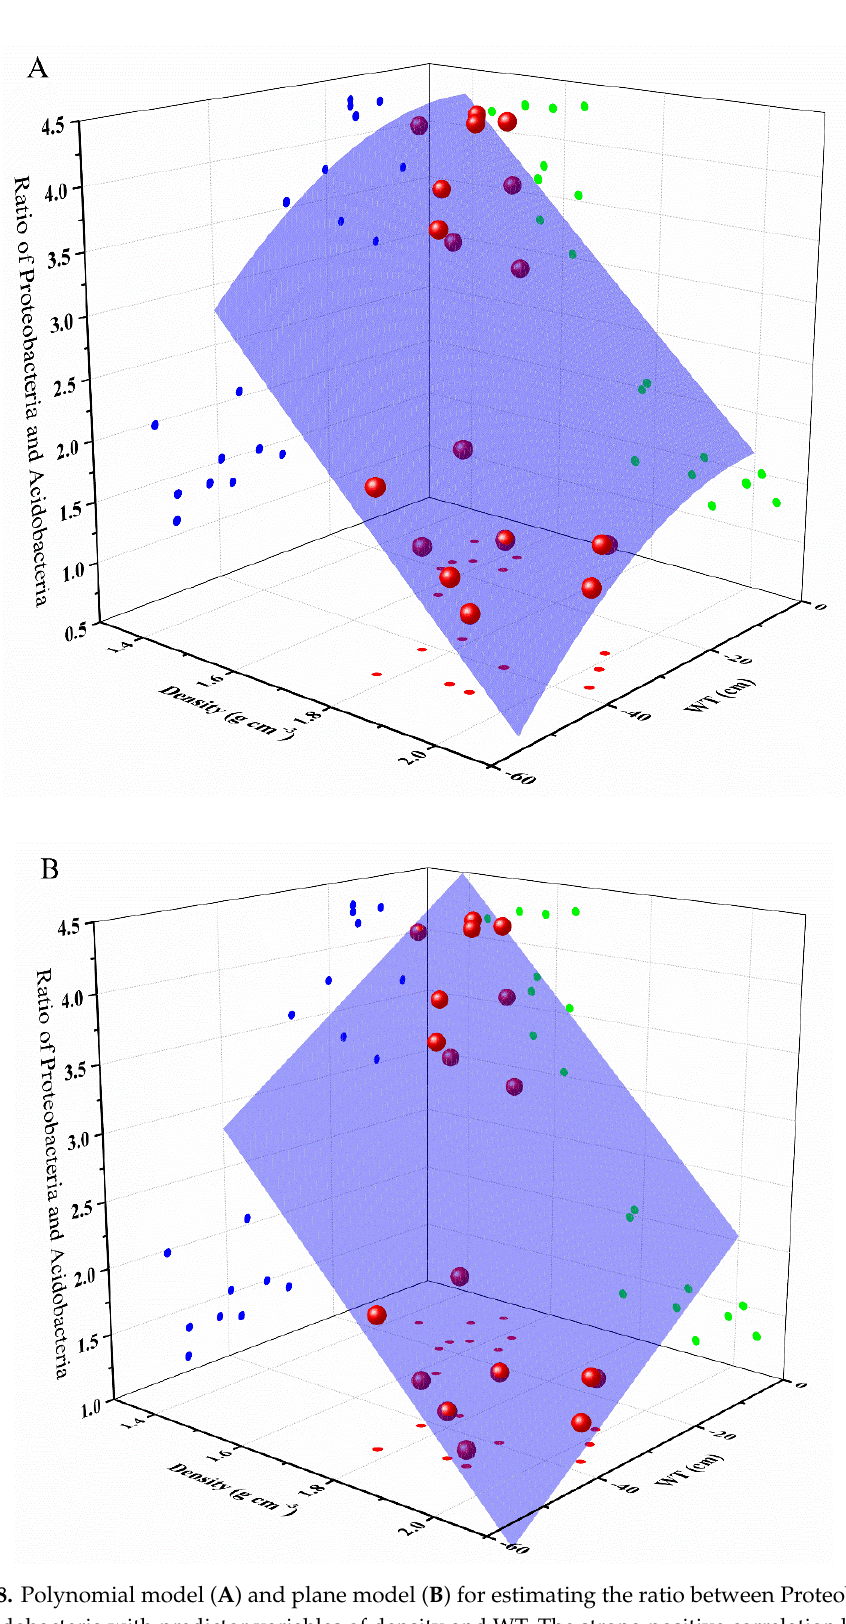
Figure 8. Polynomial model ( A ) and plane model ( B ) for estimating the ratio between Proteobacteria and Acidobacteria with predictor variables of density and WT. The strong positive correlation between the ratio and WT can be seen through the points on the a-plane, while the b-plane shows the unexpected negative correlation between the ratio and density.